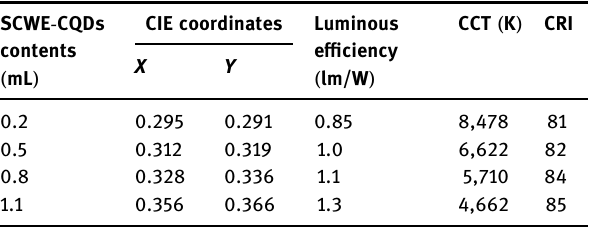
Table 3: Performance of WLEDs fabricated by adding di ff